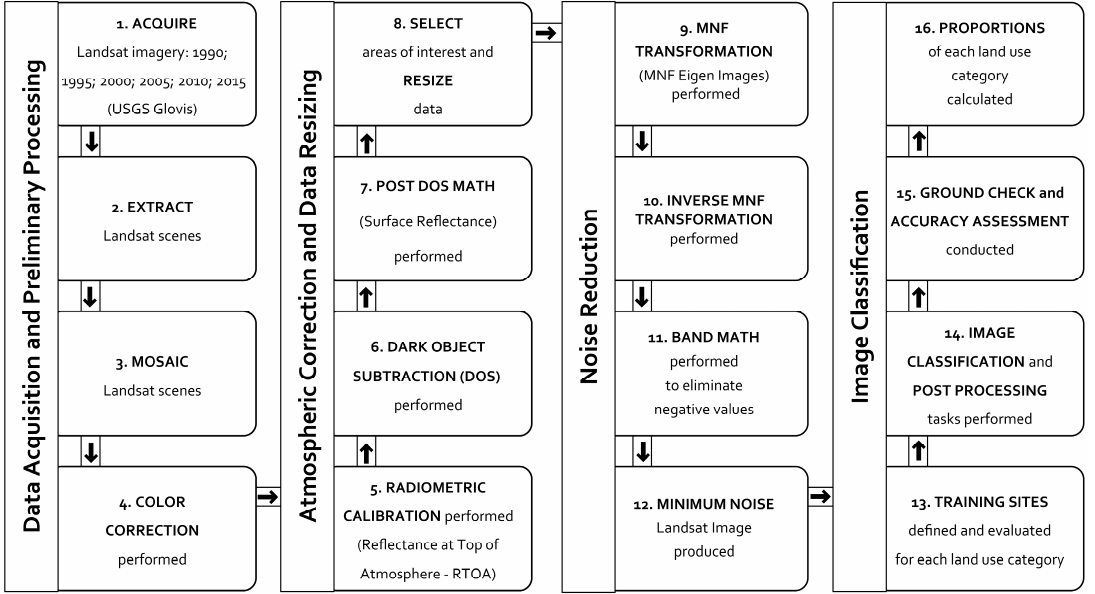
Figure 2. Workflow diagram showing integrated remote sensing—GIS methods used for the study.